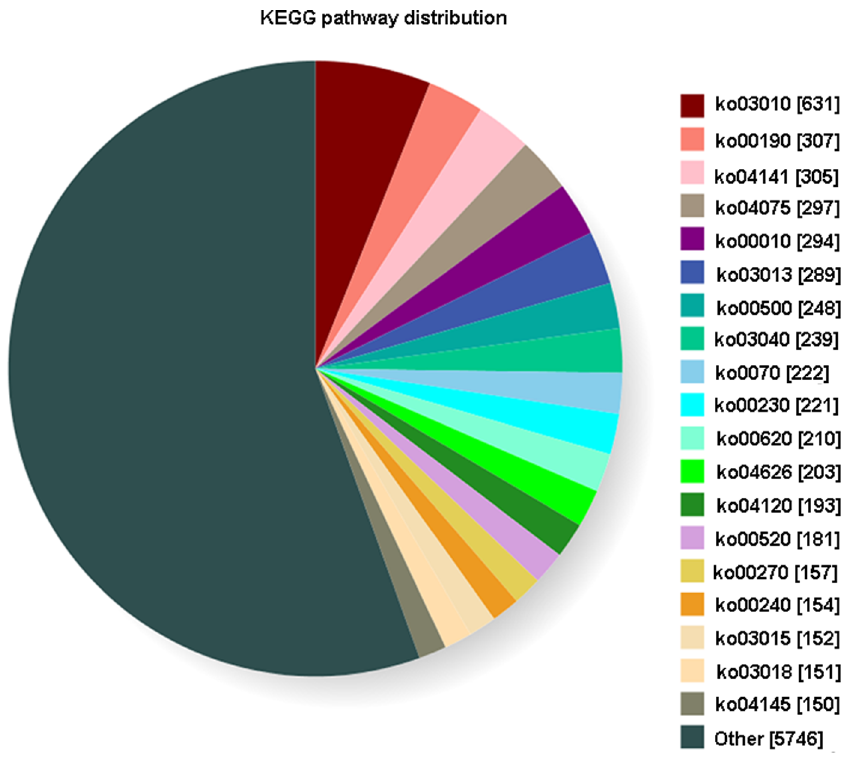
Figure 4. KEGG biochemical mappings for Youngiajaponica .